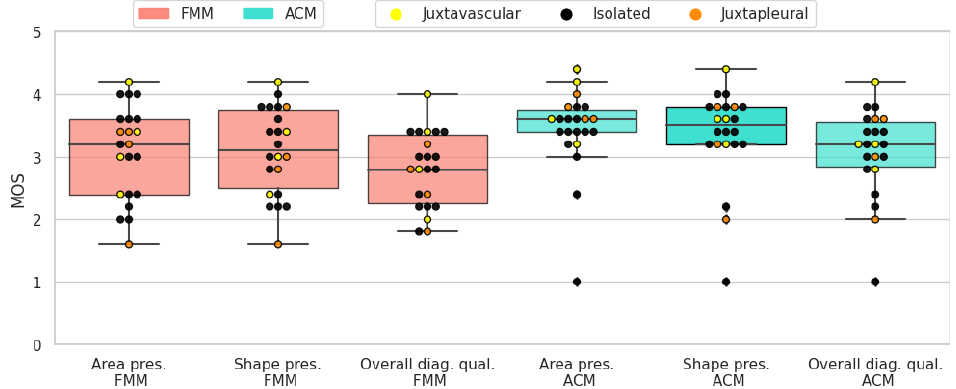
Figure 21. Sub-solid nodules’ subjective evaluation results as boxplots, overlayed with the values of individual cases divided into subcategories.